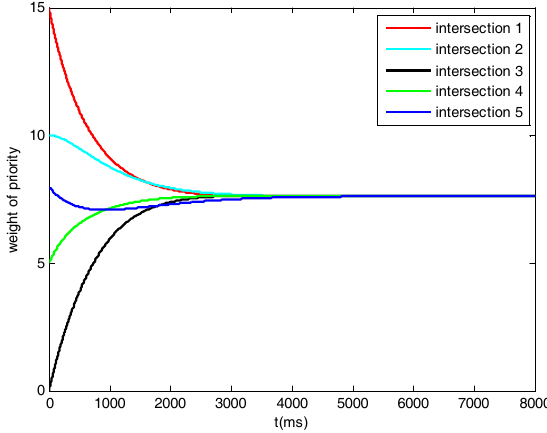
Figure 3. Simulation results of consensus algorithm in transit signal priority (TSP).